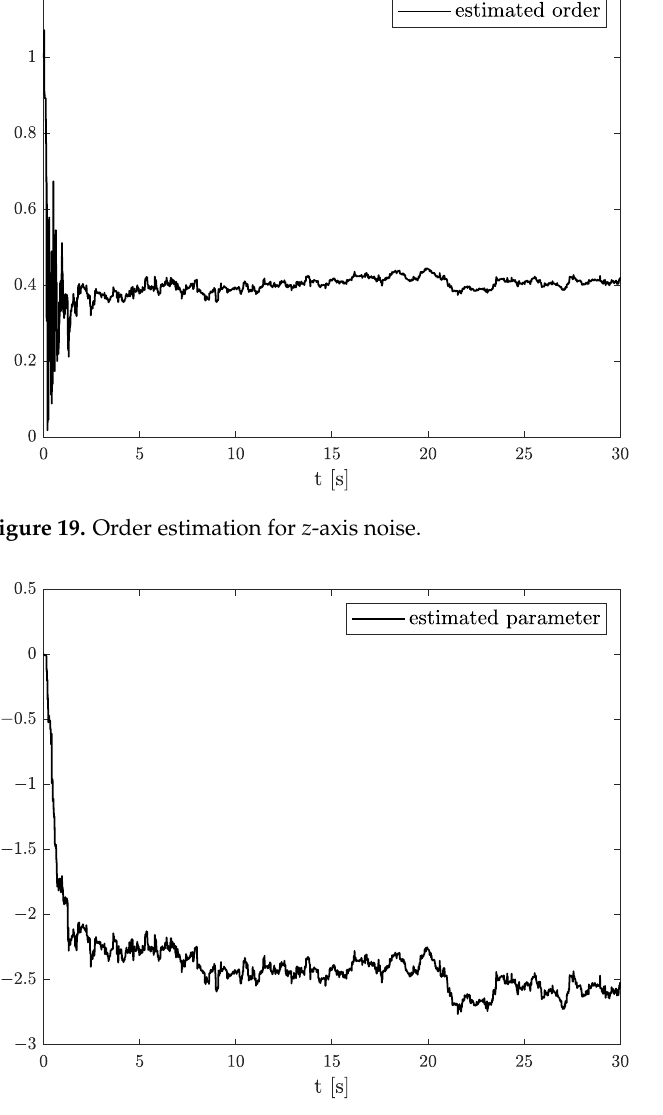
Figure 20. Parameter estimation for z -axis